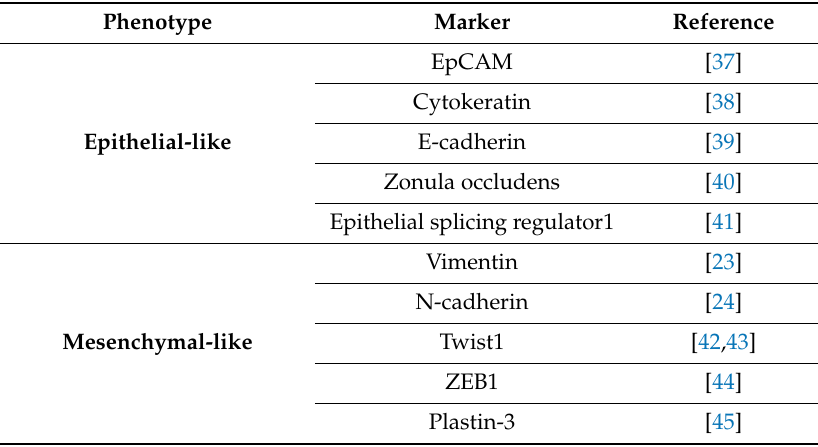
Table 1. Clinical studies that have explored phenotype of